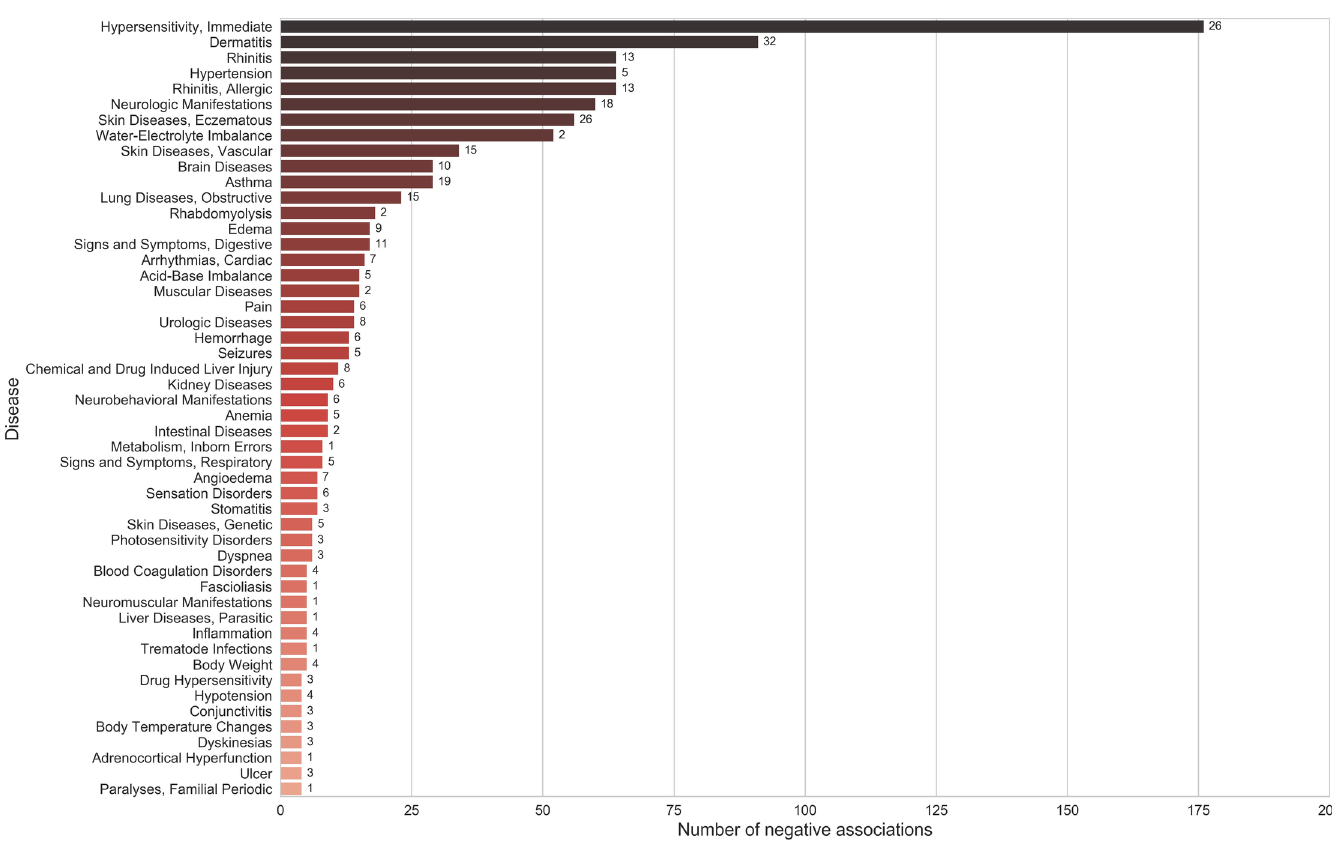
Fig 5. Top diseases (Third level of MeSH hierarchy) ranked according to their total number of negative associations. The numbers mentioned on the bars indicate the number of spices associated negatively with each disease.